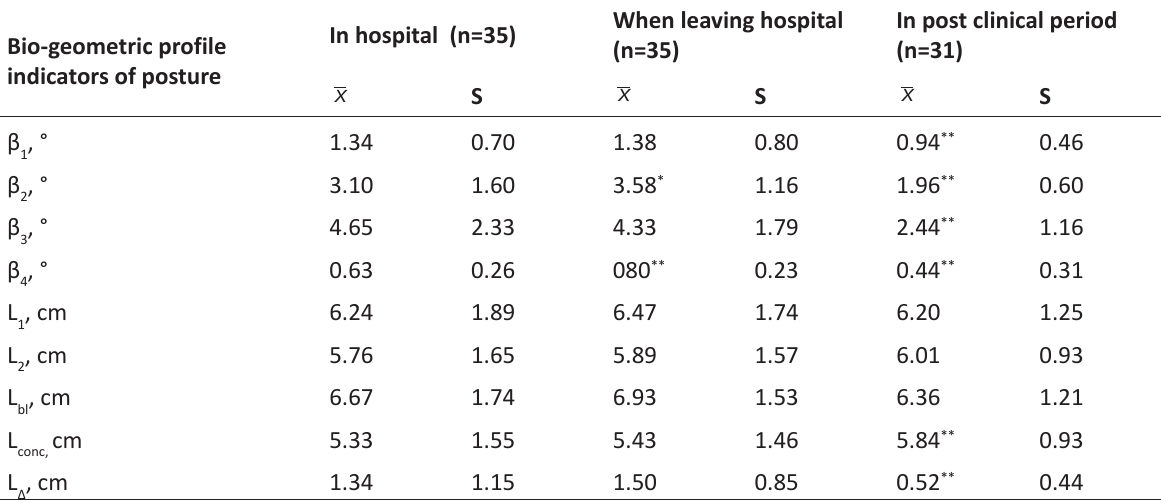
Table 1. Mean statistic indicators of bio-geometric profile of children with functionally one ventricular in frontal plane at different stages of the research